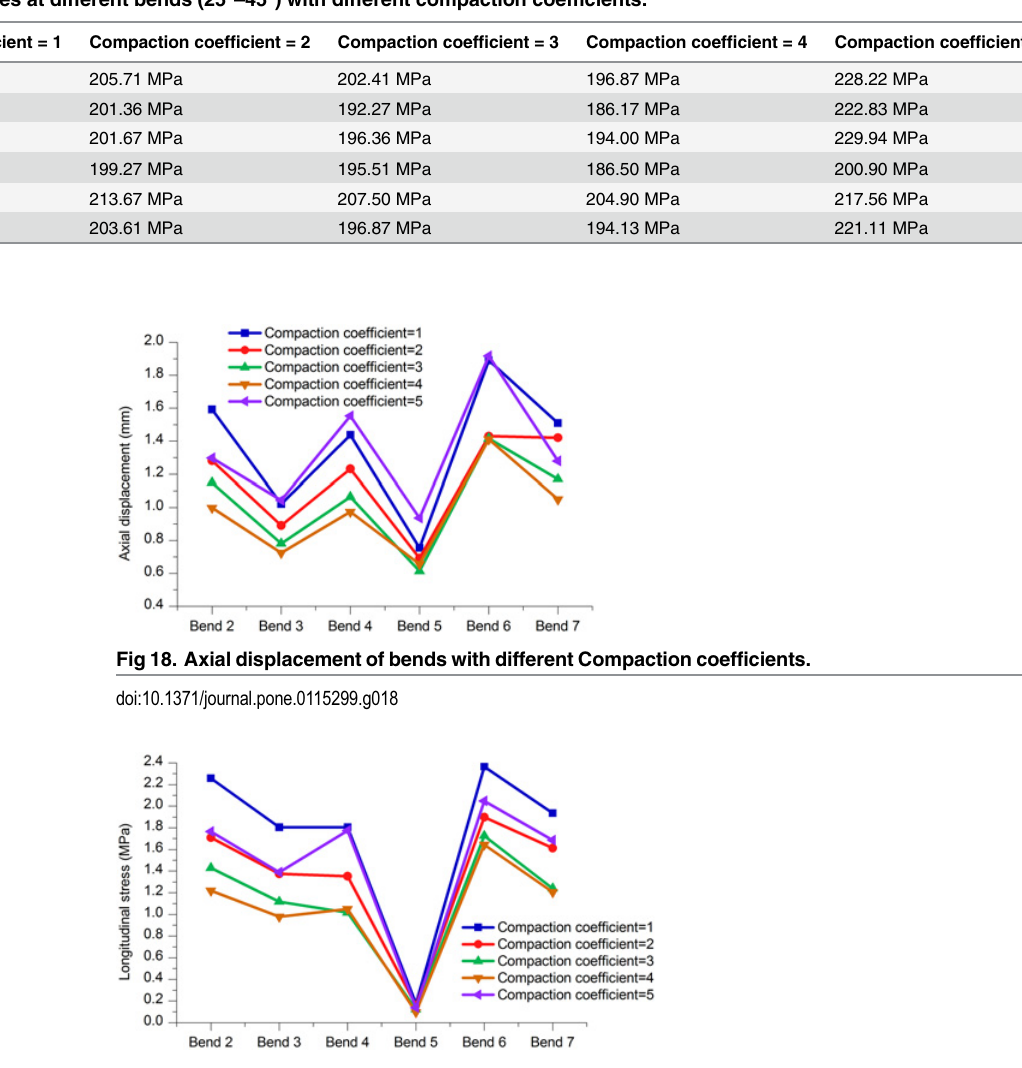
Table 14. Comparison of stresses at different bends (25° – 45°) with different compaction coef fi cients.